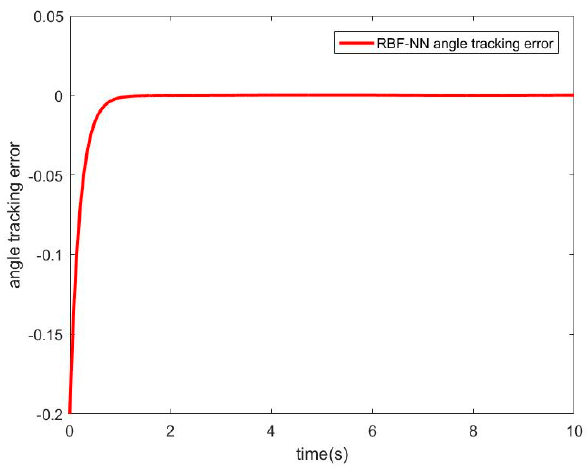
Figure 10. RBF −− NN ASMC angle tracking error with friction disturbance.